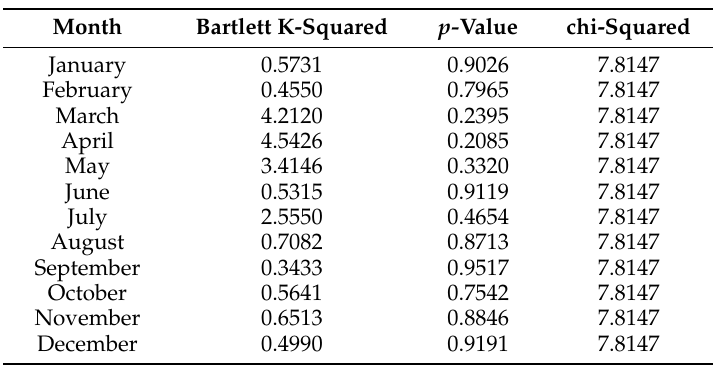
Table 2. Summary statistics showing the results of Bartlett’s test and chi-square ( α = 0.95; df = 3) to test for the homogeneity in variances in the potential squid habitat for each month within the four-year period